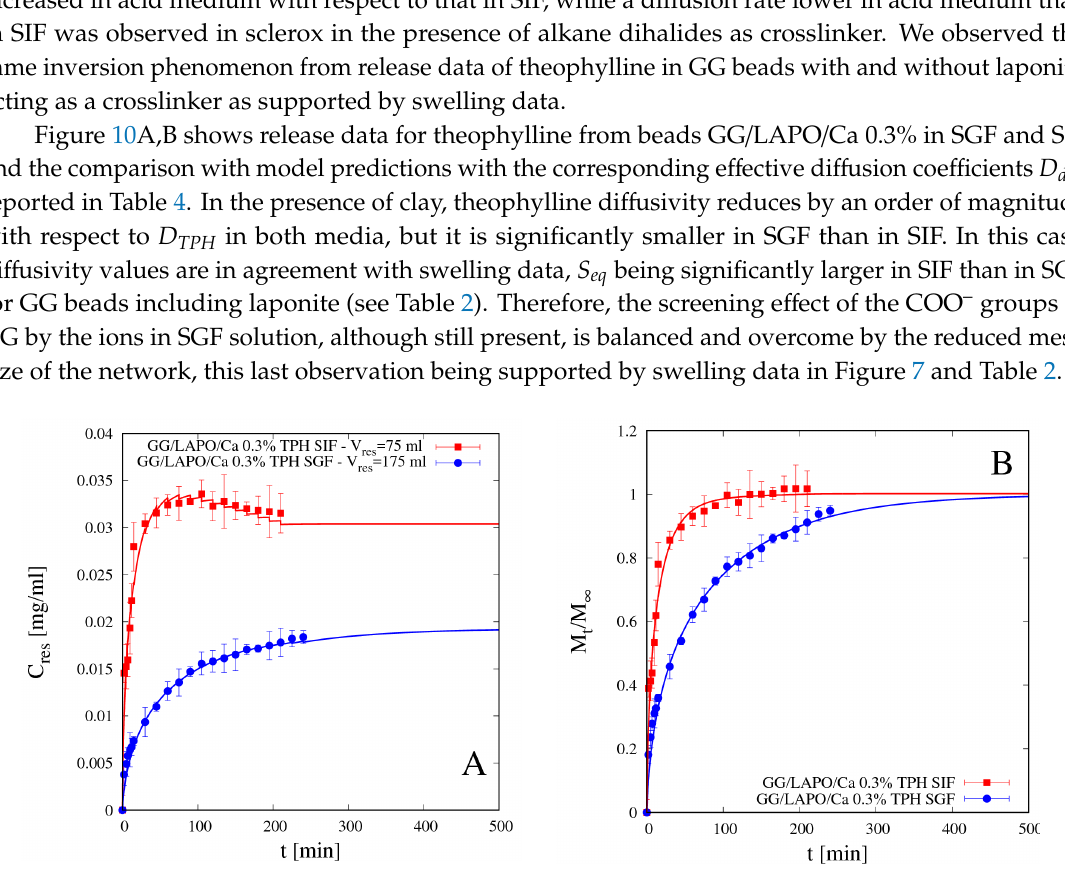
Figure 10. Differential ( A ) and integral release curves ( B ) for theophylline (TPH) from beads GG/LAPO/Ca 0.3% with laponite in SGF and SIF. Continuous lines represent model predictions from